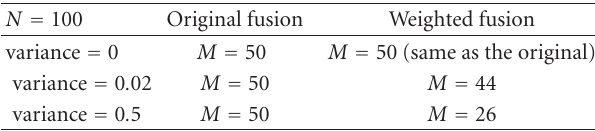
Figure 8: Assigned weight for CRs at di ff erent distance when weight variance = 0 . 5. Table 3: Comparing the original and the weighted